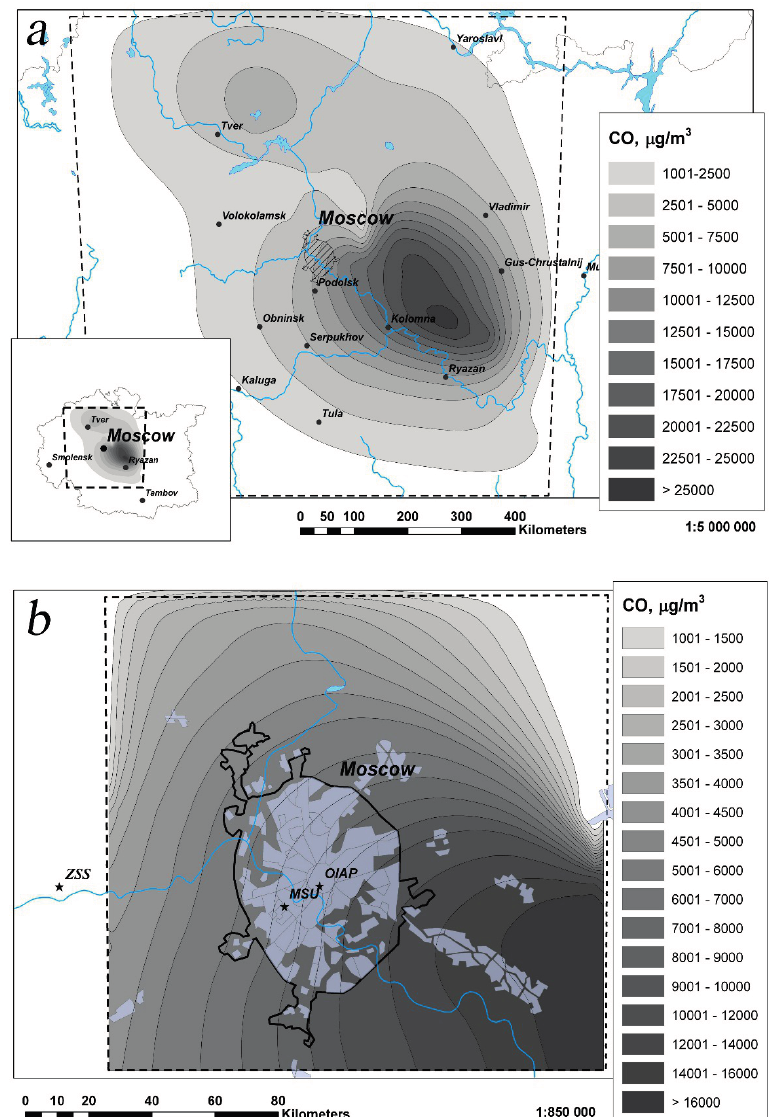
Figure 7. The spatial distribution of CO near Moscow at height of 155.5 m a.g.l., 8 August 2010 9:00 UTC, the domain-II ( a ) and domain-III ( b ) RAMS/HYPACT (Terra hot spots). Scale for CO starts at 1000 μ g/m 3 . The dashed line corresponds to the domains. In addition the residential areas and the city contour (as it is in 2010) are shown in (b). The positions of observational stations are marked as stars in the third domain